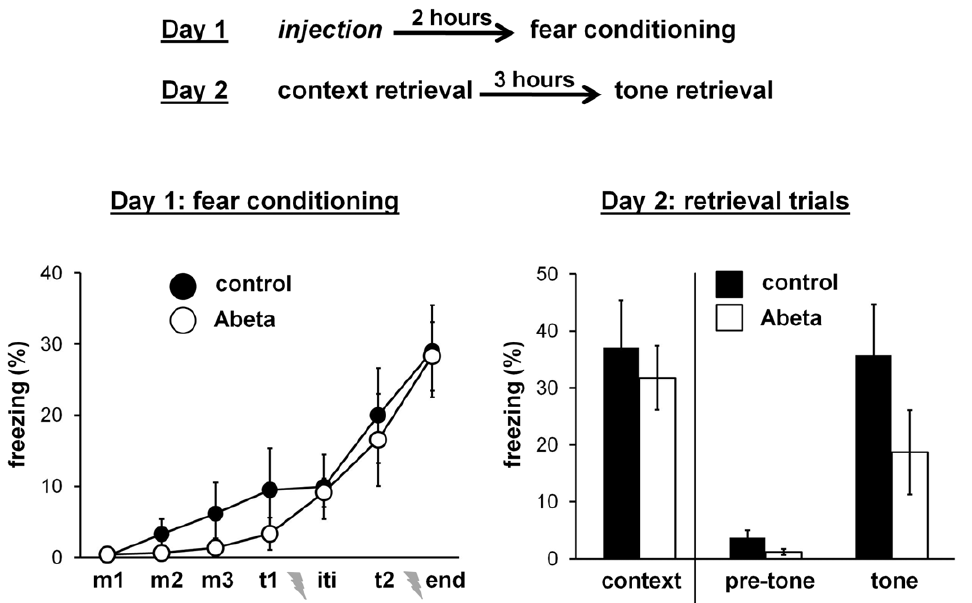
Figure 4. Experiment 3: single Abeta injection 2 hours before fear conditioning. Top) Diagram showing the design of experiment 3. Separate groups of mice were injected one time with either control or Abeta solution 2 hours before fear conditioning. Bottom) Graphs showing average freezing scores during fear conditioning on day 1 and the two retrieval trials on day 2. There was no difference during any of the intervals analyzed between mice injected with the Abeta solution (n=10) and mice injected with the control solution (n=8). Error bars are standard errors of means.